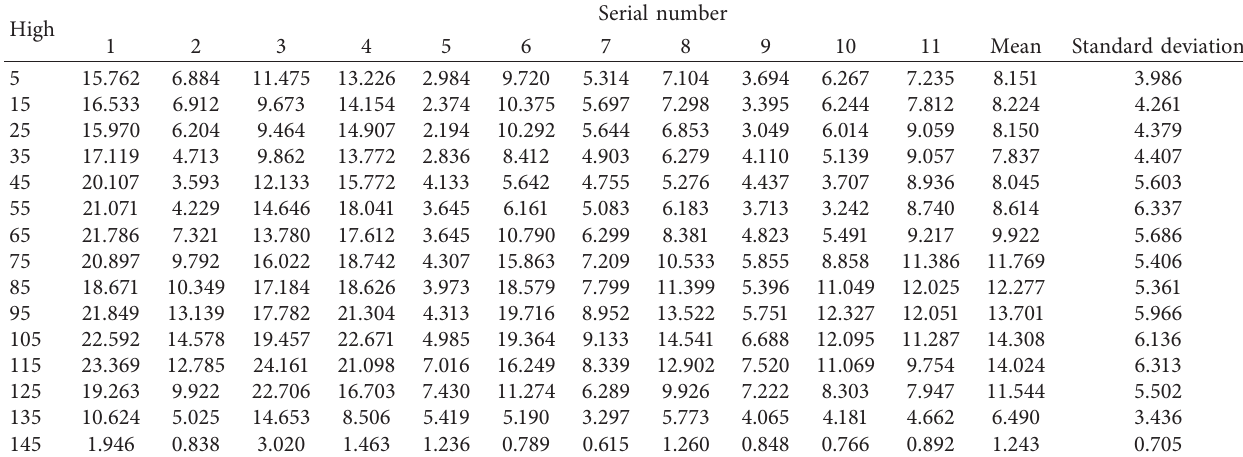
Table 14: Maximum earthquake tensile stresses of the 150m high chimney when only horizontal seismic acceleration is inputted.